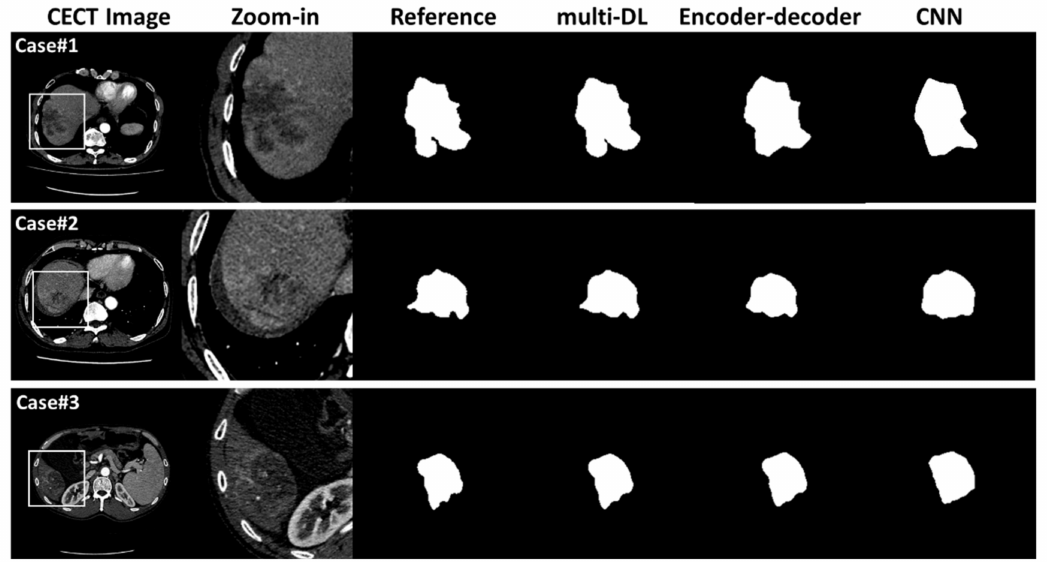
Figure 6. Tumor segmentation for three cases with reference manual segmentation, results of multi- DL, CNN, and encoder–decoder